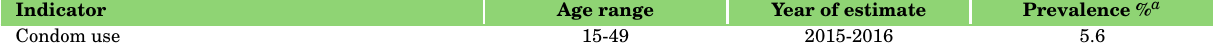
Table 48: Prevalence of condom use in